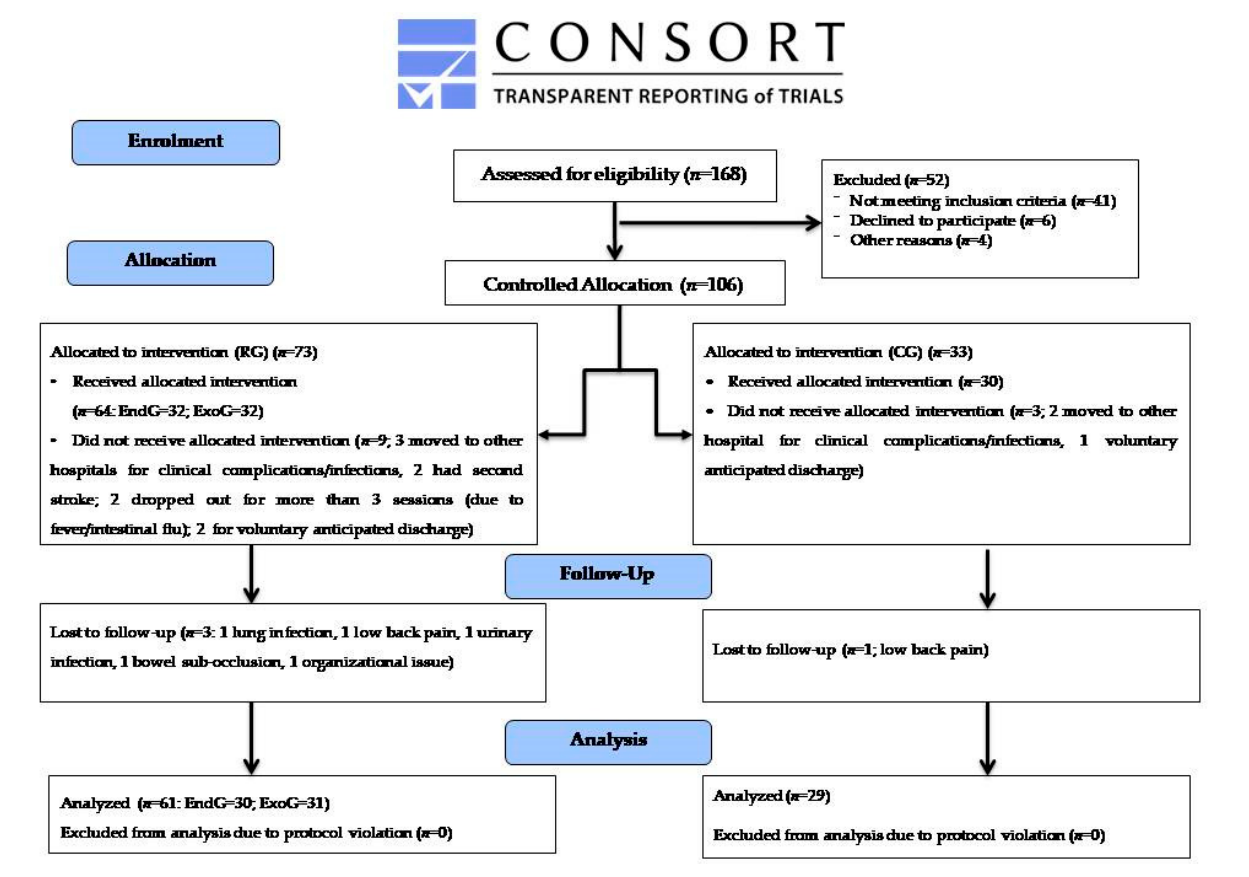
Figure 1. Consort flow-chart. Table 1. Demographic and clinical characteristics of the Robotic Group (RG) and Control Group (CG) at baseline (T0).